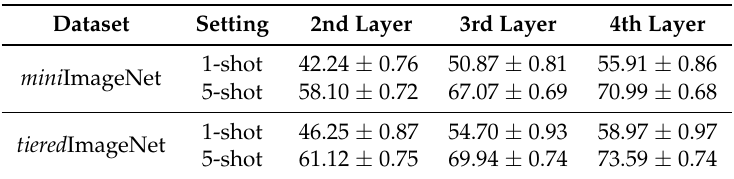
Table 6. Different layers’ prediction accuracy (in %) on 5-way tasks after label propagation with same-shot